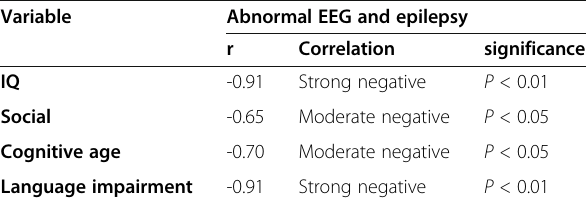
Table 5 Spearman correlation between language impairment, cognitive age, social, IQ, and abnormal EEG and epilepsy